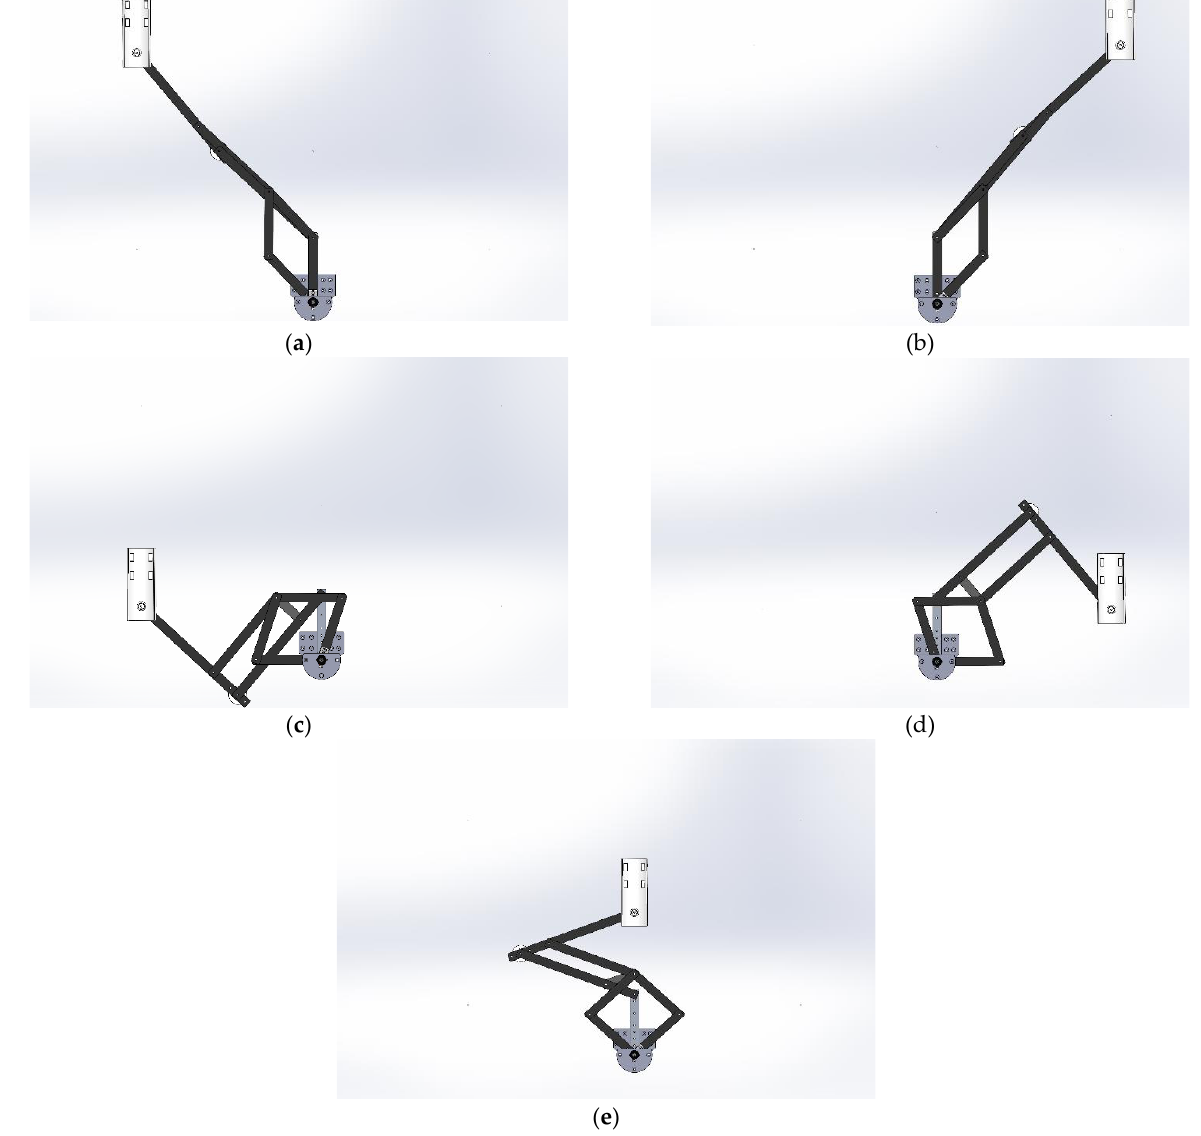
Figure 9. Nurse device on critical positions: ( a ) critical position a ( − 496, 700); ( b ) critical position b (496, 700); ( c ) critical position c ( − 496, 148); ( d ) critical position d (496, 148); ( e ) critical position e (0,